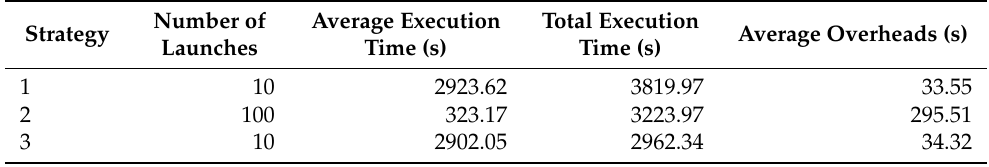
Table 2. Experimental